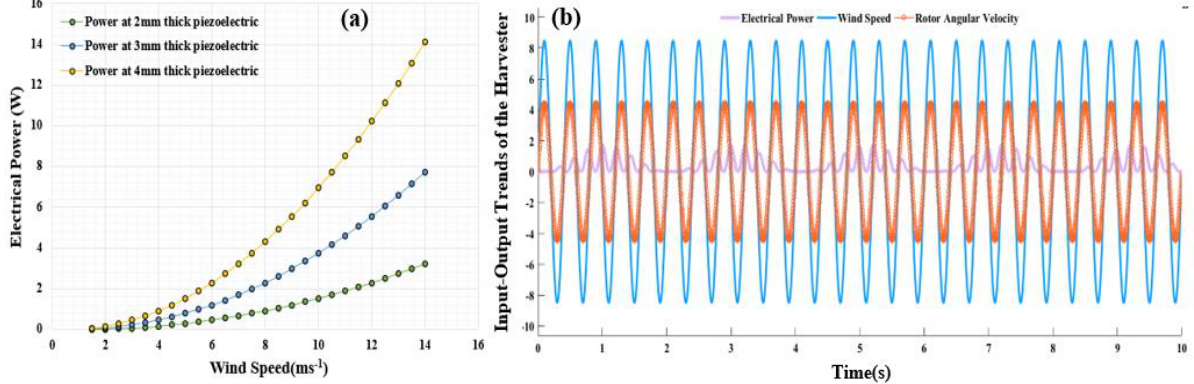
Figure 8. The response of the harvester. ( a ) Electrical power via wind speed, ( b ) Time varying trends of the harvester.